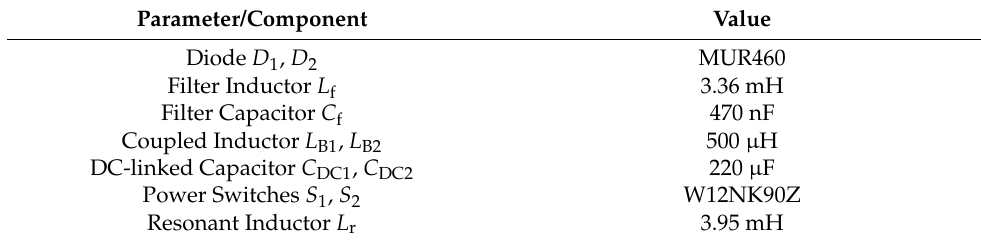
Table 4. Components utilized in the prototype of the proposed drive circuit.